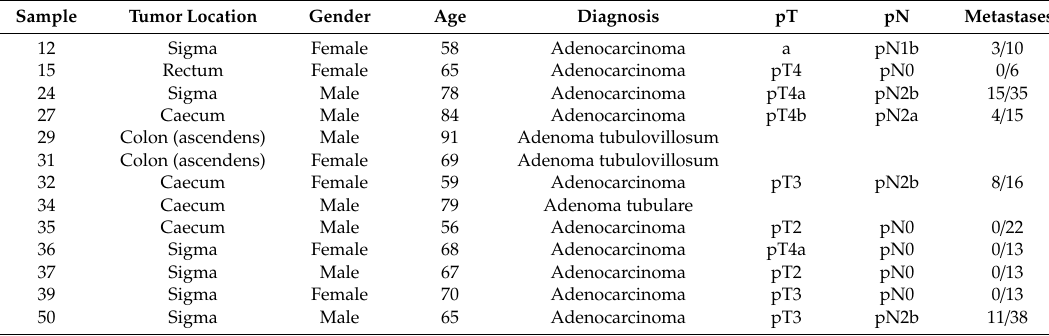
Table 2. The characteristics of the human patients and tumors used in the study. pT and pN according to TNM Classification of Malignant Tumors (TNM); p is the stage given by histopathological examination, T is the size of the primary tumor, and N the nearby lymph nodes